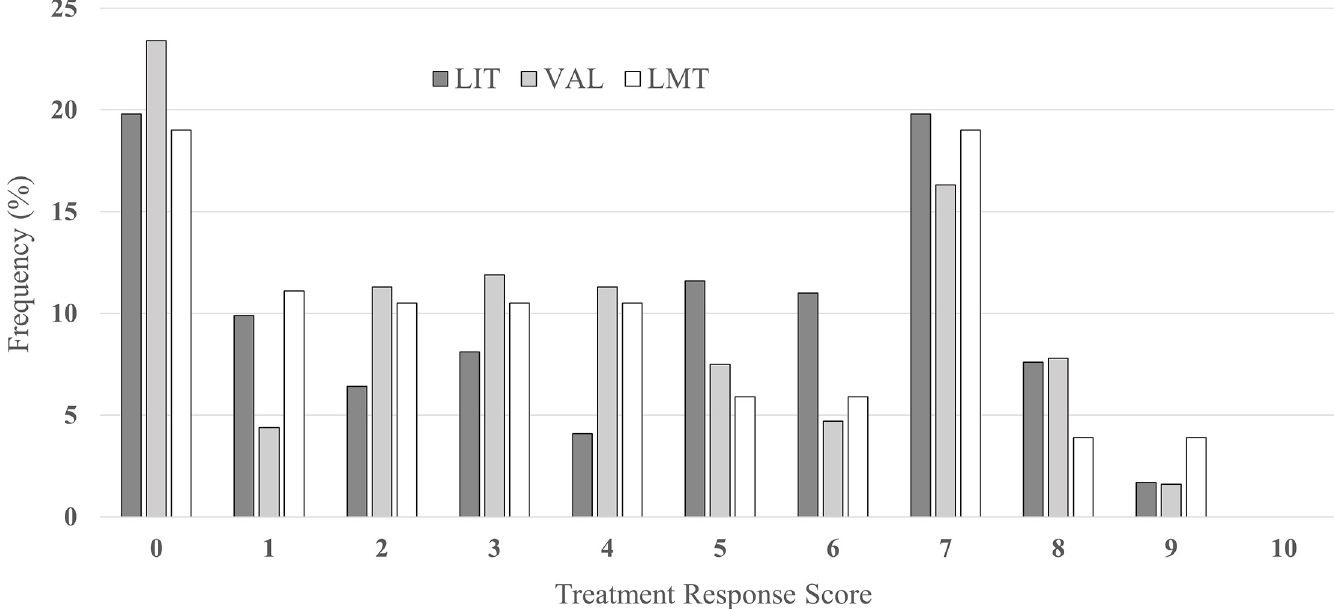
Fig 1. Distribution of treatment response scores for lithium, valproate and lamotrigine.